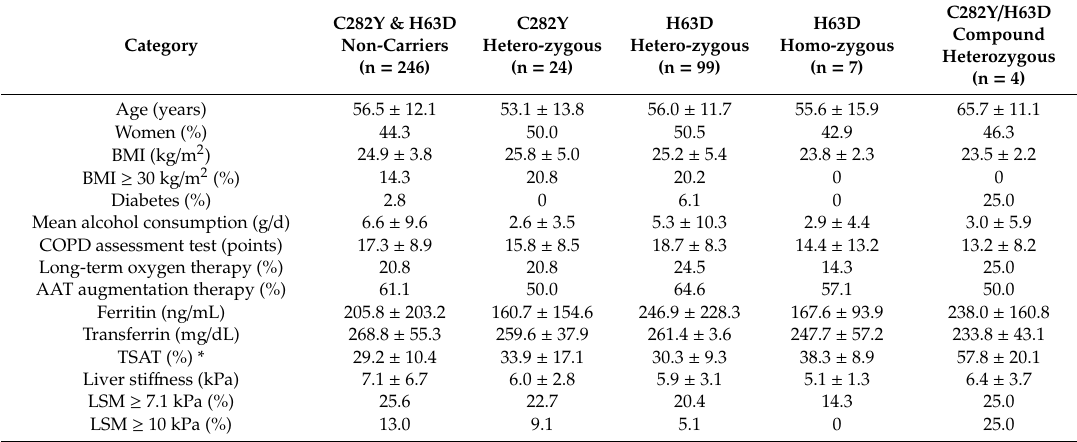
Table 4. Characteristics of Pi*ZZ subjects subdivided based on presence of C282Y and H63D variants in the HFE gene. None of the patients was homozygous for the C282Y variant, hence this group was not shown. Quantitative measures are expressed as mean ± standard deviation or as relative frequency